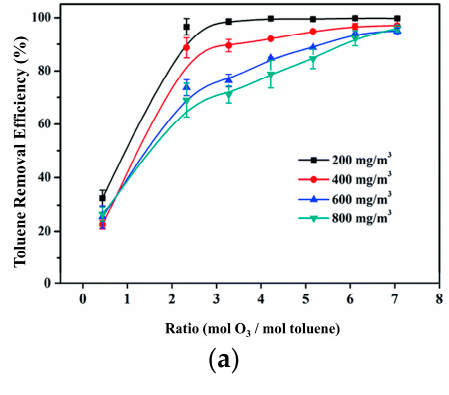
Figure 7. ( a ) Removal of toluene at different initial toluene concentrations with ZnFe 2 O 4 /g-Al 2 O 3 catalyst. Reprinted with permission: Royal Society of Chemistry 2020 [44]; ( b ) the effects of inlet concentrations of ethyl acetate on catalytic performance of Pd/ACF catalyst (ozone concentration: 500 mg·m 3 ). Reprinted with permission: Elsevier 2018 [56].